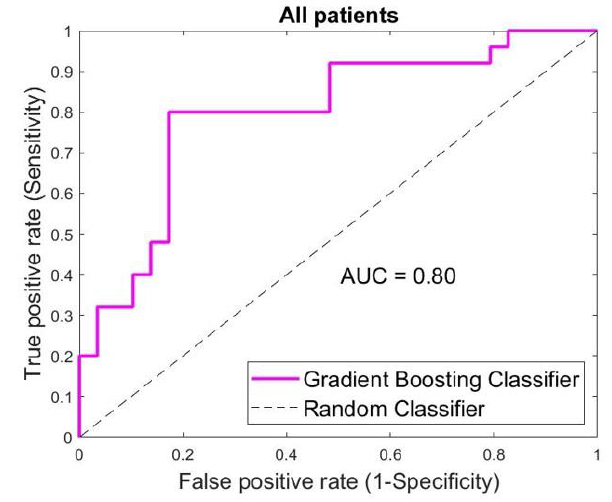
Figure 3. Classification outcome for all patients involved in the study. SAFE correctly classified 44 out of 54 lesions achieving sensitivity, specificity and accuracy of 80%, 83% and 81%, respectively.